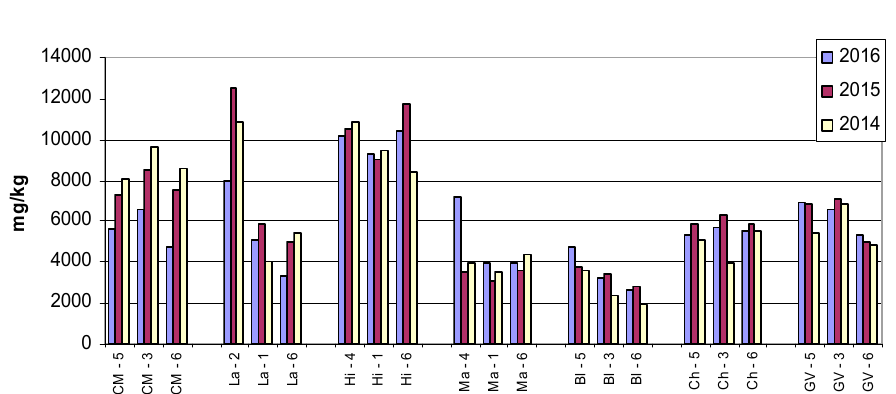
Figure 4. Total content of stilbenes in grape canes during three years. Example explanation of abbreviations: CM-5—“CM” is the variety, “5” is the sampling site (see Materials and Methods and Table 1).